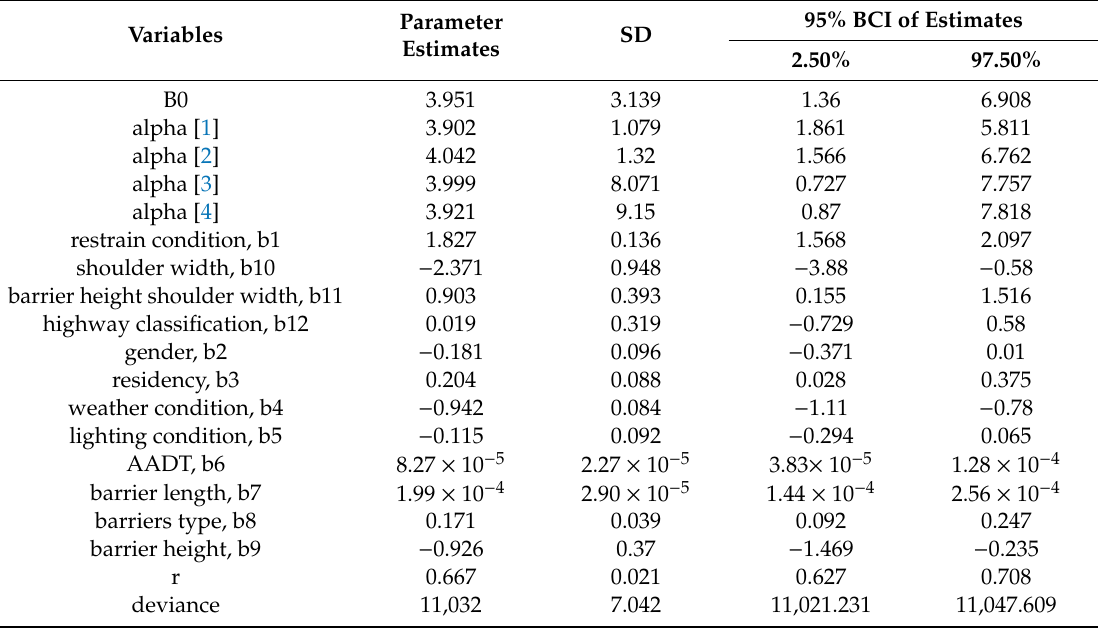
Table 2. Results of a finalist model, with an objective